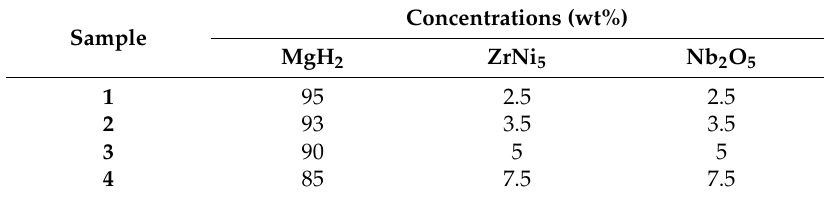
Table 4. Batches of as-prepared nanocomposite powders with different catalytic